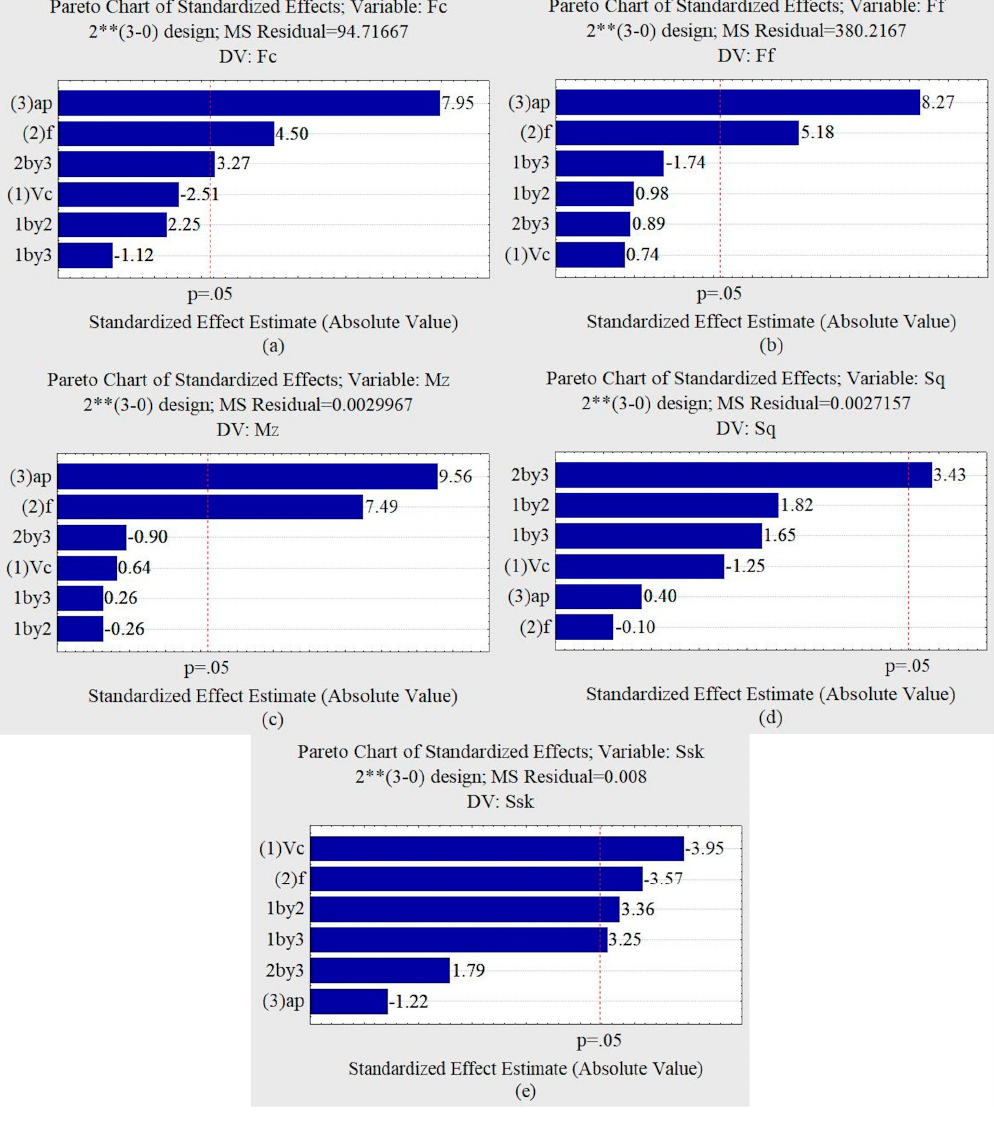
Figure 14. Pareto charts for oil machining condition. ( a ) Force F c . ( b ) Force F f . ( c ) Torque M z . ( d ) Roughness S q . ( e ) Skewness of height distribution.